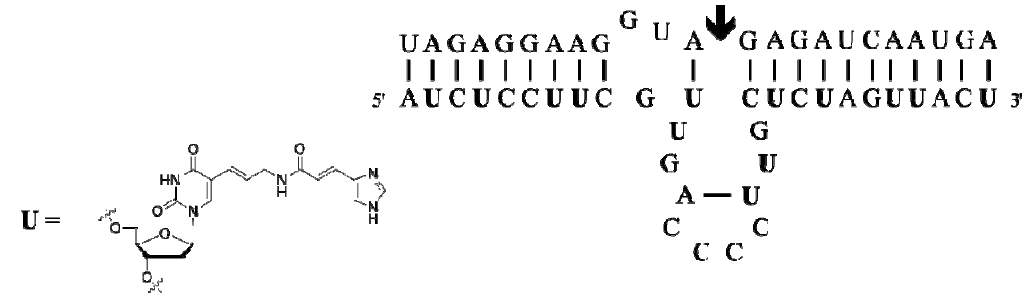
Figure 4. Sequence and hypothetical 2D structure of Dz16.2-11 (bold-face U ’s indicate the position of the modified nucleoside; the arrow shows the cleavage site within the RNA substrate)